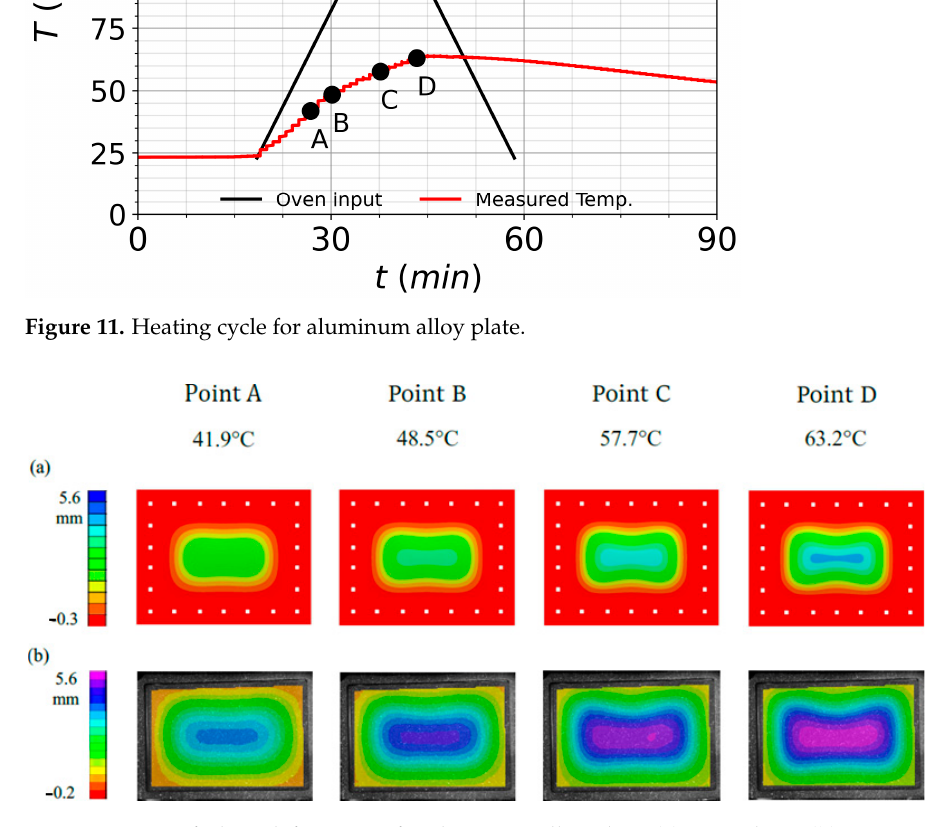
Figure 13. Temperature vs. out-of-plane deformation for the three plates. The second test was performed on the composite plate with [30/−30/5/−5] (cid:3046) layup. A graph of temperature as a function of time is reported in Figure 14. The ideal tempera- ture cycle is represented as a black bold line, labelled as “Oven input”. In practice the plate never reaches the programmed temperature, so a prediction was performed to ensure that the desired temperature was reached; this estimation, represented as a bold violet line, was performed using data from two preliminary tests, where the plate was heated at two different temperature rates. This violet line was also used for the numerical simulation of